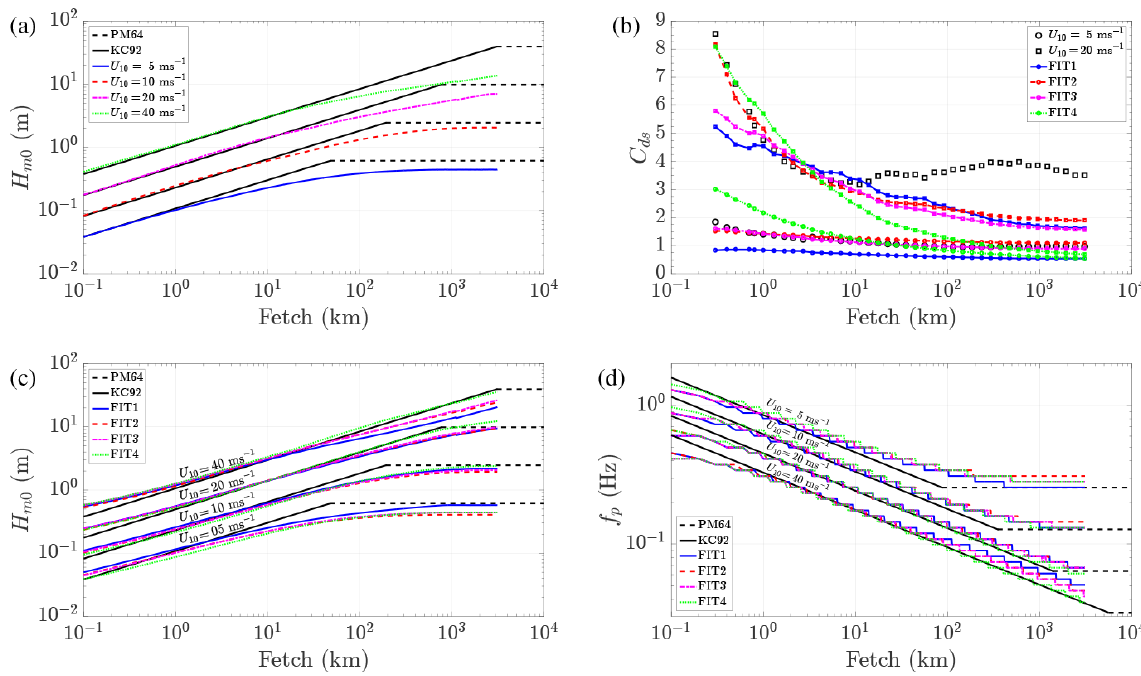
Figure 2. H m 0 as a function of fetch after 72h of simulation in different wind speed conditions using Eq. (21) as the white-capping dissipation parameter (a) . C ds as a function of fetch after 72h of simulation in different wind speed conditions using Eq. (21), and fitted C ds using FIT1 to FIT4 (b) . H m 0 and f p as a function of fetch using white-capping dissipation parameters from FIT1 to FIT4 (c, d)